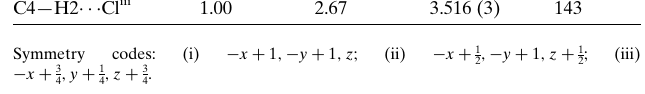
Table 4 Hydrogen-bond geometry (A˚ , (cid:5) ) for 6